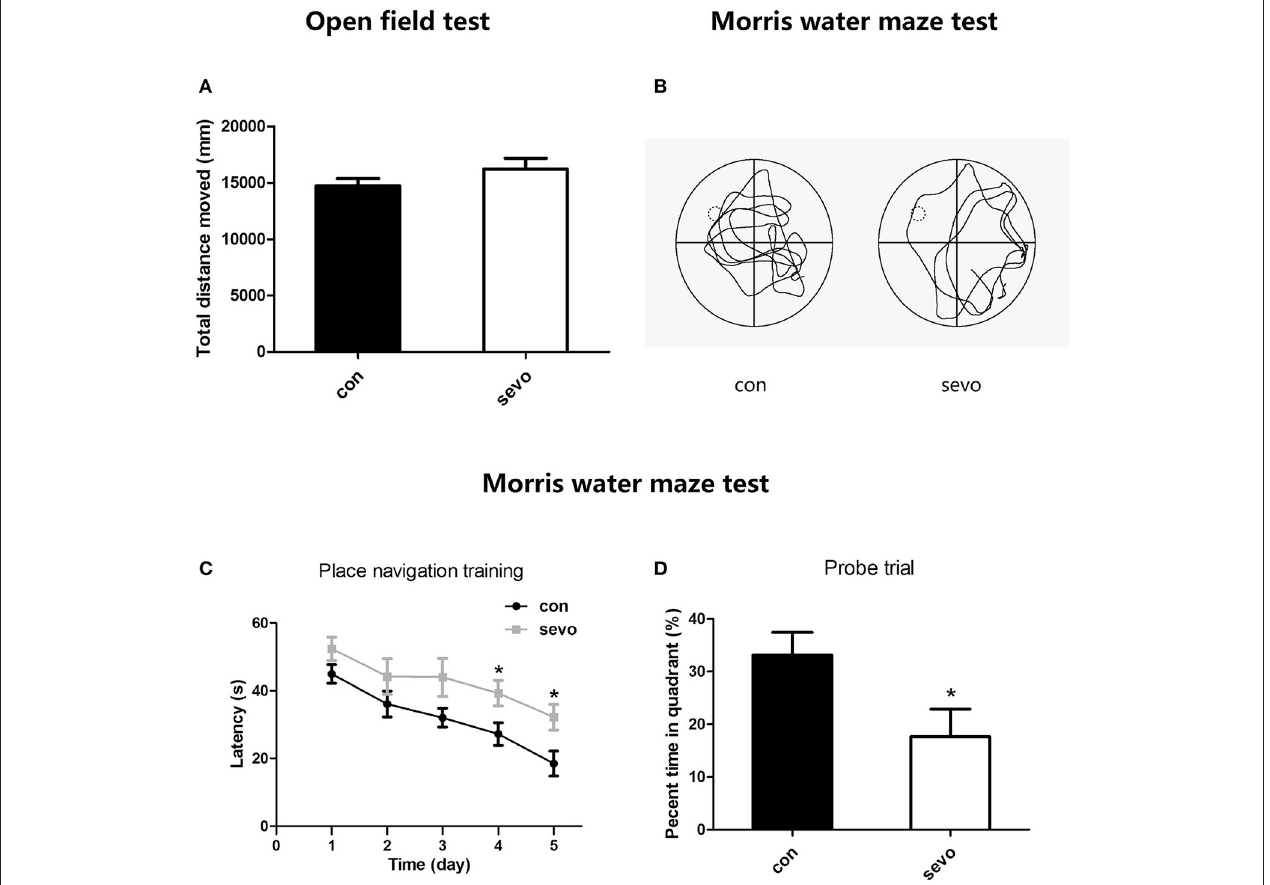
FIGURE 2 | Effects of repeated early-life sevoflurane exposure on behavior. (A) In the open field test, no significant difference was observed between the control group and the sevoflurane group in total distance moved. (B) A typical path during the probe trial for each group. (C) The latency to find the platform during the place navigation training phase of the Morris water maze test. (D) The percentage of time spent in the target quadrant during the probe trial of the Morris water maze test. N = 10 rats for each group. Repeated ANOVA with a post hoc least significant difference (LSD) test and unpaired t -tests were performed for (A,C,D) , respectively; * p < 0.05. Data are presented as the mean ±